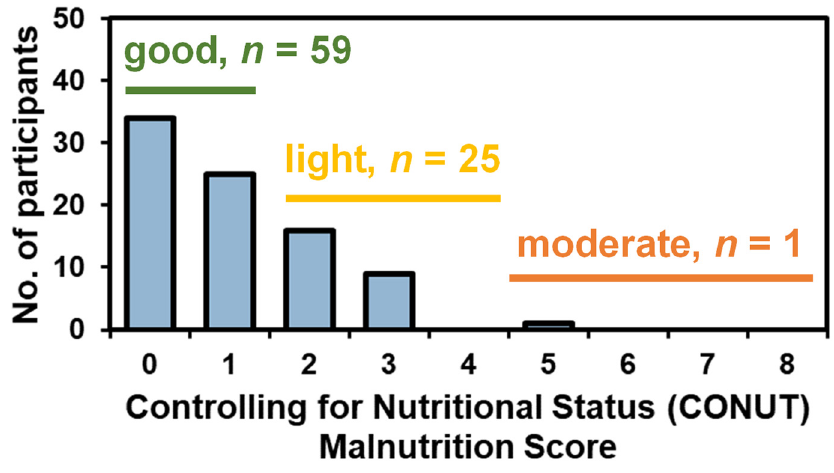
Figure 1. Controlling for nutritional status (CONUT) distribution in our cohort ( n = 85).